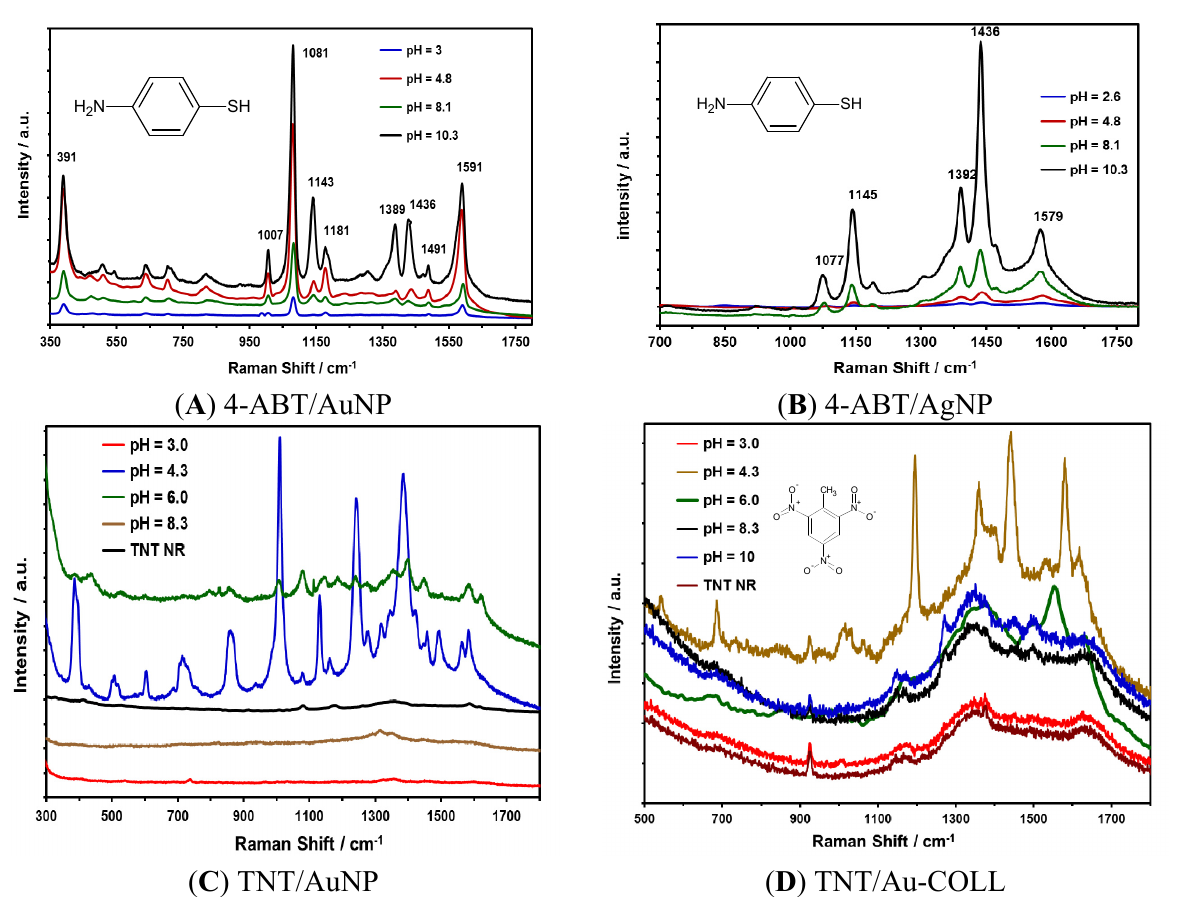
Figure 6. pH effect on SERS activity: ( A ) SERS spectra of 4-ABT on the Au NPs/Au substrate; ( B ) SERS spectra of 4-ABT on the Ag NPs/Au substrate; ( C ) TNT SERS spectra on the Au NPs/Au substrate; and ( D ) SERS spectra of TNT interacting with a Au colloidal suspension, included for